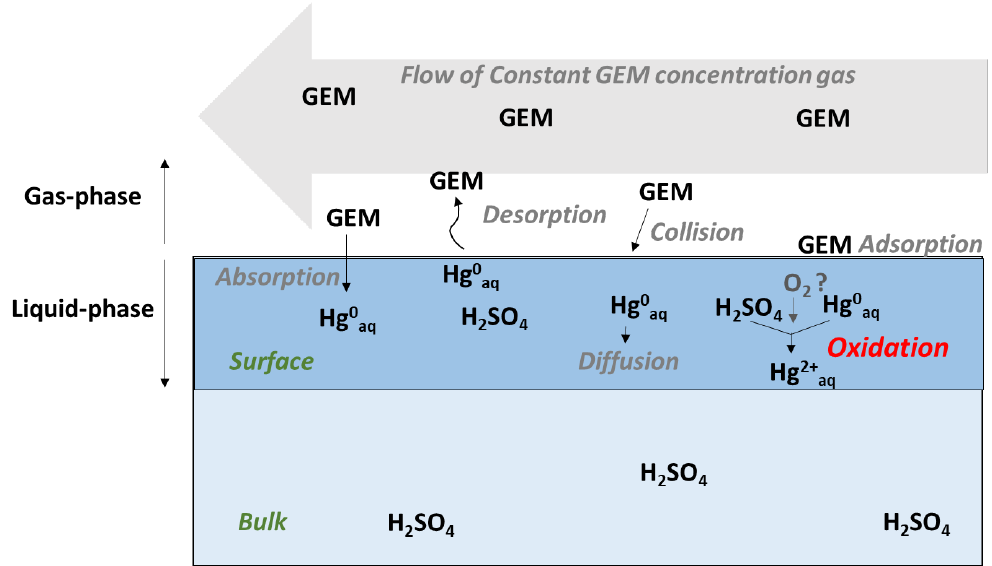
Figure 5. A schematic illustration for the oxidation of gaseous elemental mercury in the liquid phase of the acidified water with sulfuric acid.